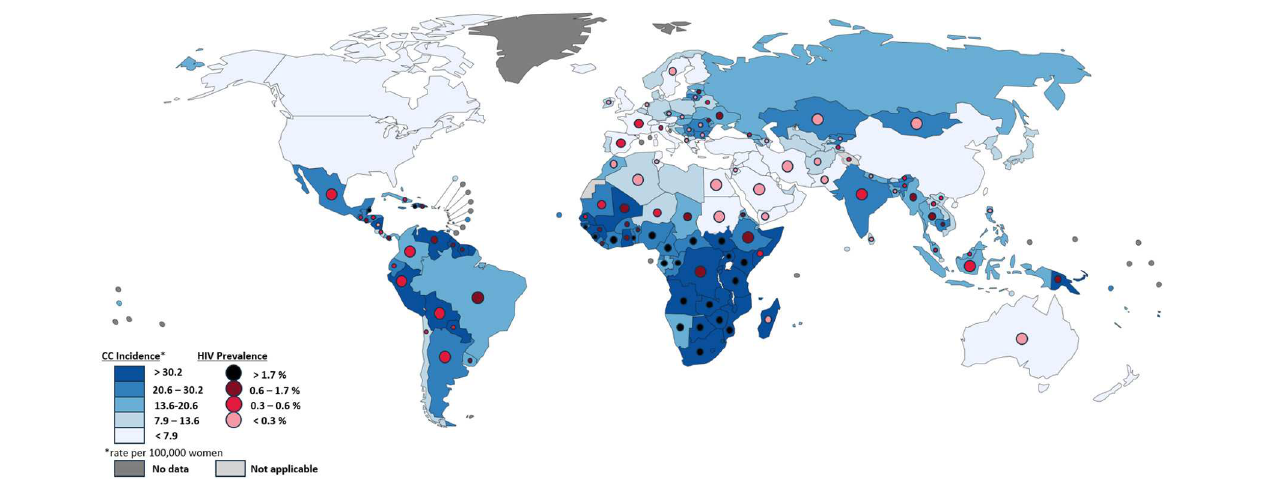
FIGURE 1 | Comparison of cervical cancer incidence and HIV Prevalence by country. Each country is colored by cervical cancer incidence per 100,000 women, as described in the bottom left, based on data from GLOBOCAN 2012. Circles within each country’s borders are colored by HIV prevalence, as described in the bottom left, based on data from UNAIDS (2016). Differences in the size of circles within countries is only for visibility and does not signify anything meaningful. Countries without HIV prevalence circles did not have such data available. Map produced by IARC.